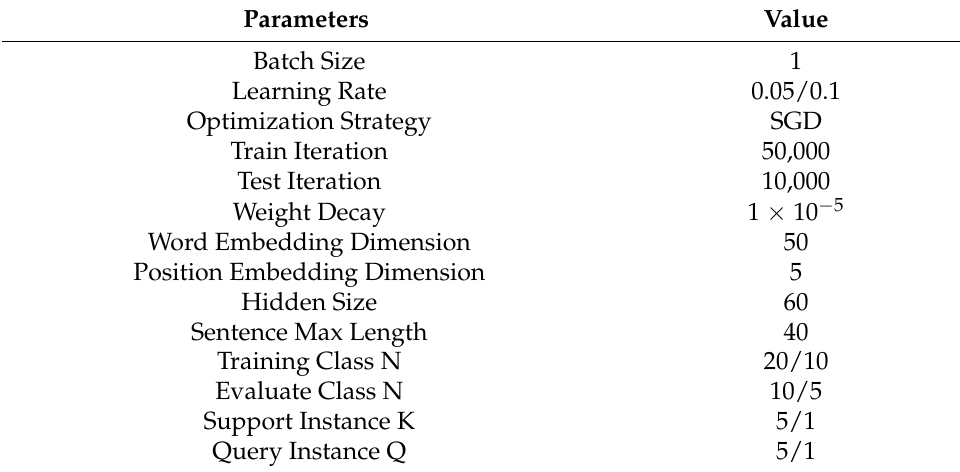
Table 4. Model parameter settings.